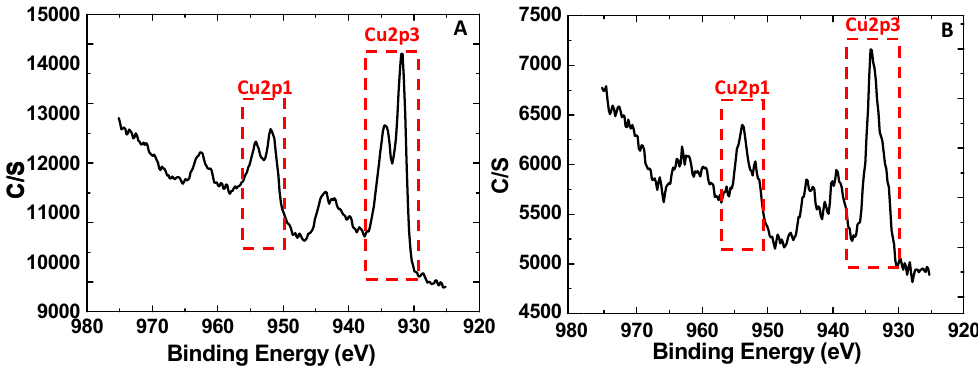
Figure 4. The X-ray photoelectron spectra for ( A ): Cu(I/II)BTC after the reduction of Cu(II)BTC; ( B ) the starting Cu(II)BTC material synthesized at 140 °C and 180 min of reaction.